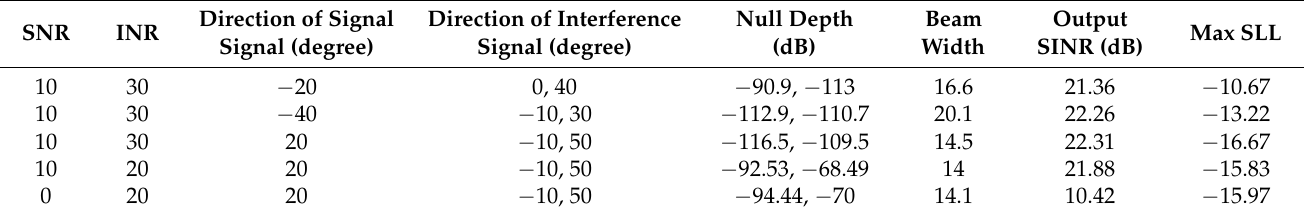
Table 3. Beamforming analysis with different beam pattern gains.